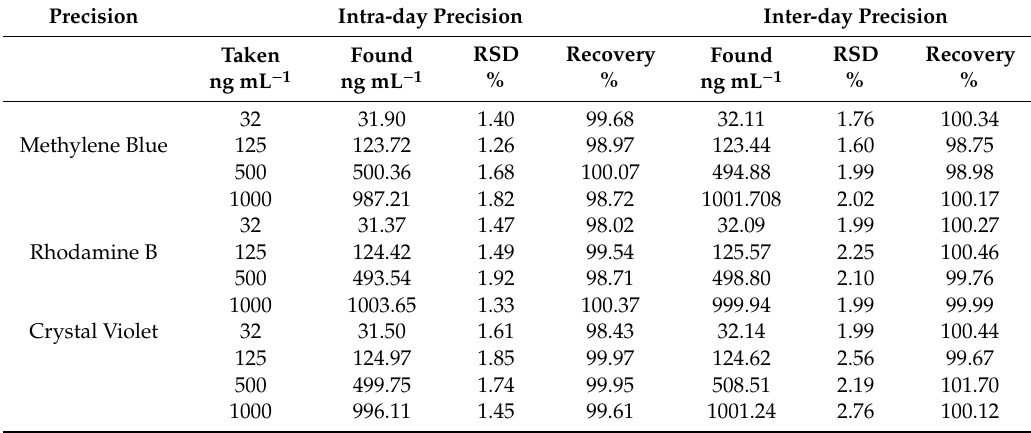
Table 3. Accuracy and precision study for the determination of methylene blue, rhodamine B and crystal